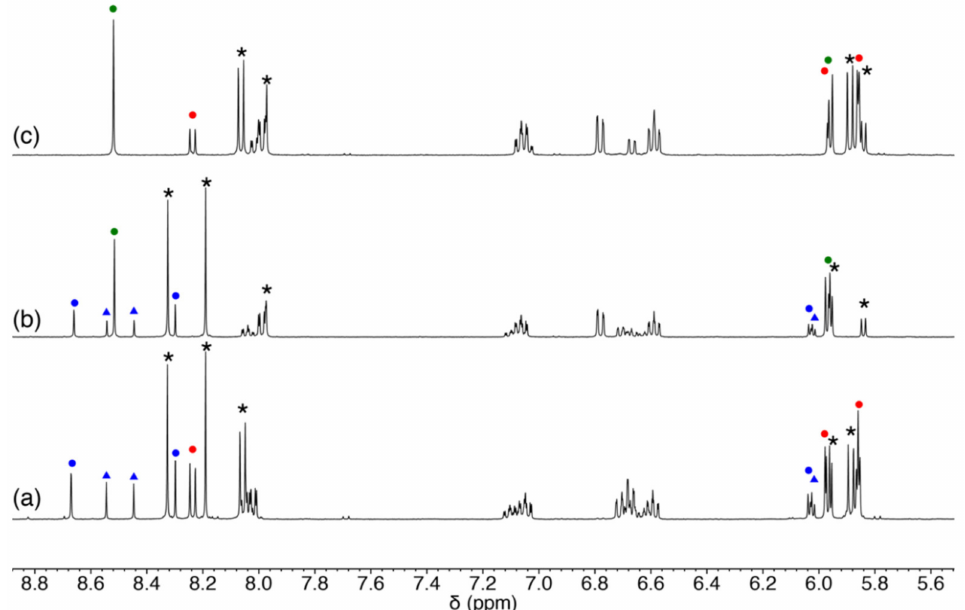
Figure 13. 1 H NMR spectra of 1 with two different nucleosides in CD 3 OD. ( a ) Adenosine and cytidine, ( b ) adenosine and guanosine, and ( c ) guanosine and cytidine. The resonances attributed to the major and minor products for each nucleoside are indicated with solid circles and triangles, respectively (the resonances for Amp 2 − ligand for each species are not marked). Pd-A , Pd-G , and Pd-C species are shown in blue, green, and red, respectively. Asterisks indicate unreacted